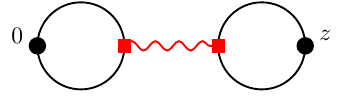
Figure 13 . Quark-disconnected diagram for the QED correction to a